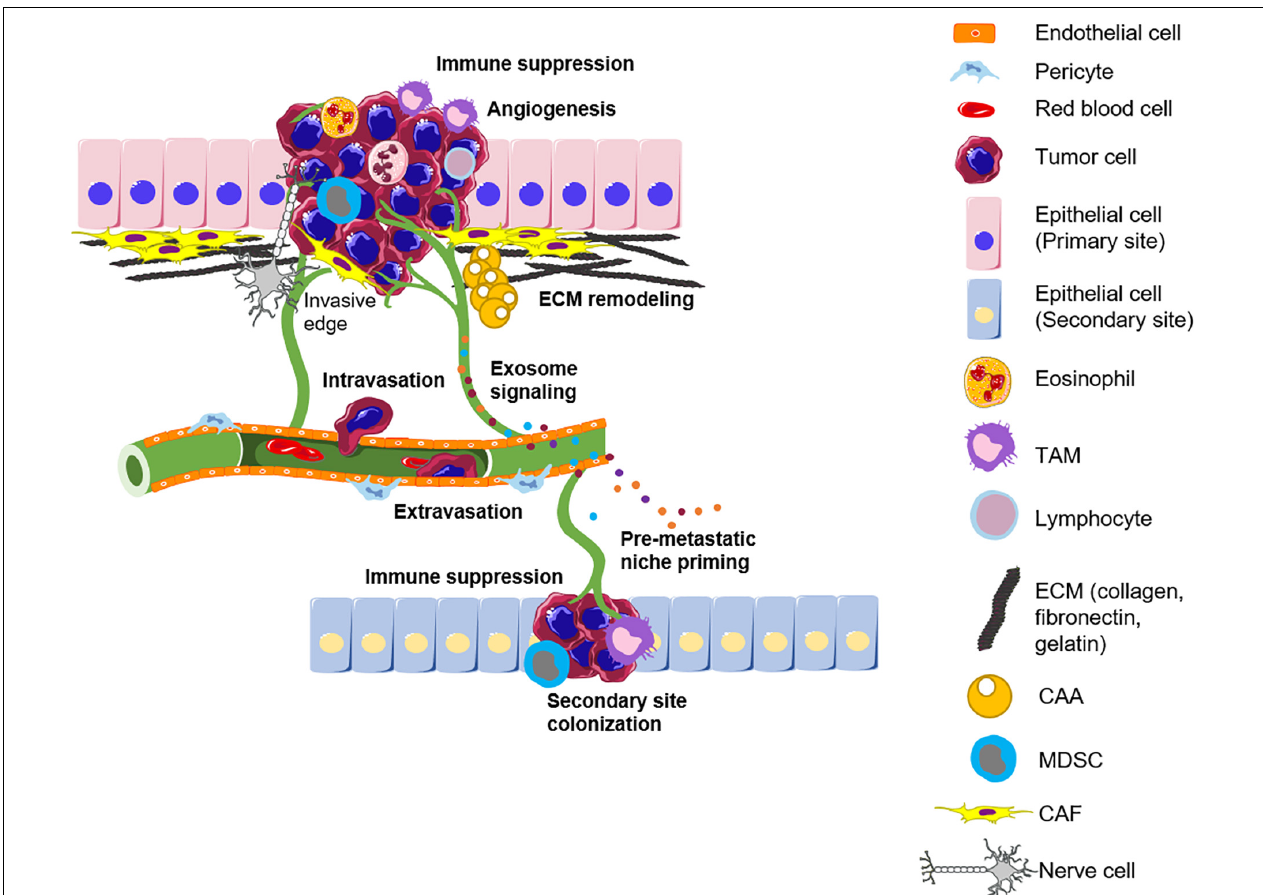
FIGURE 1 | The tumor microenvironment influences the different stages of cancer progression. The primary tumor is infiltrated by different immune subsets and surrounded by a remodeled matrix. Angiogenesis ensures tumor growth by supplying nutrients and also provides a route for metastasis. Intravasation of tumor cells into blood vessels allows their shuttling to a novel site. The secondary site is primed by exosomes secreted by tumor cells and the different actors of the TME to allow the successful seeding of incoming tumor cells. TAM, Tumor-associated macrophage; ECM, Extracellular matrix; CAA, Cancer-associated adipocytes; MDSC, Myeloid-derived suppressor cells; CAF, Cancer-associated fibroblast; TME, Tumor microenvironment.